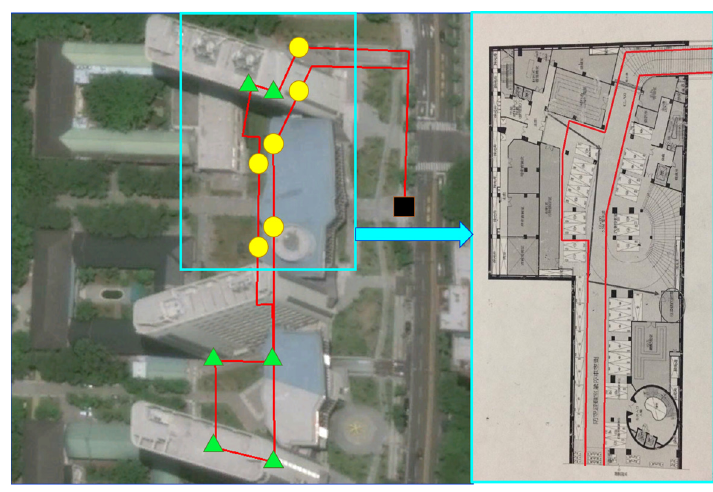
Figure 13. The experimental route.